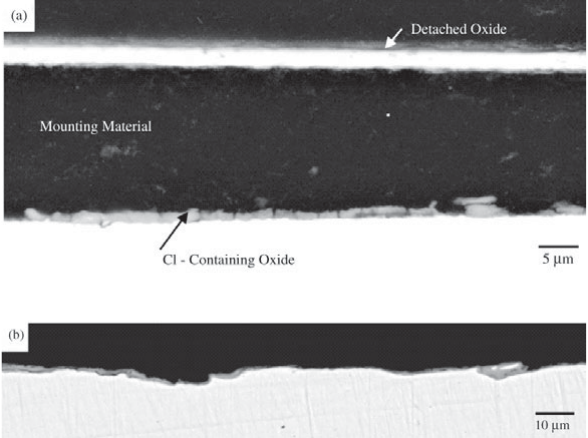
Figure 10. Backscattered SEM images of cross-sectioned specimen tested at 400 °C in 50 ppm HCl. a) From the surface that underwent static oxidation; b) from the maximum wastage